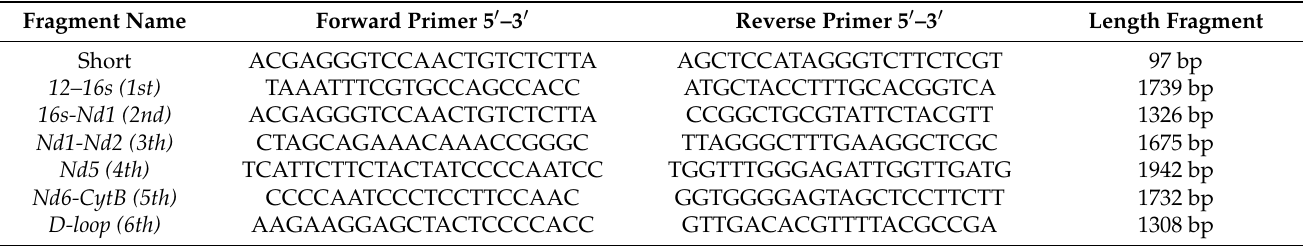
Table 5. Primer sequences for measurement of mtDNA